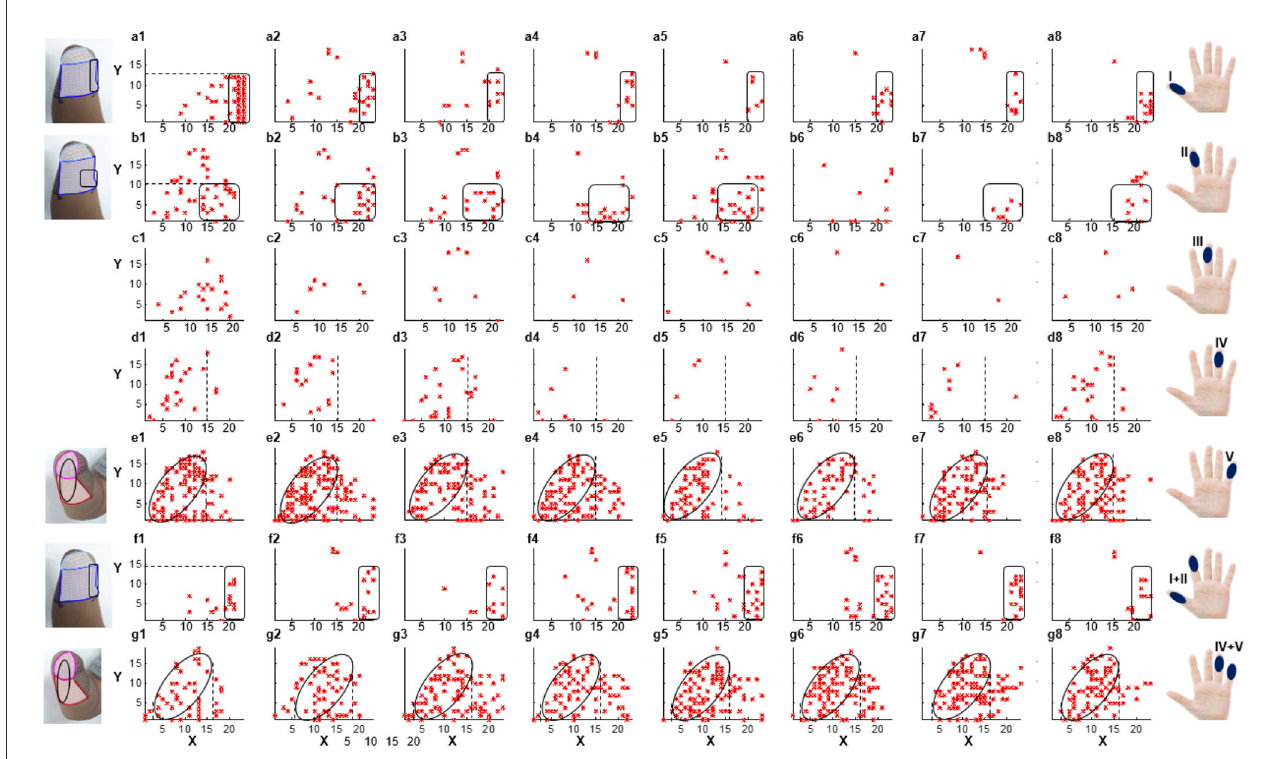
FIGURE3 The distribution of PHMs for the thumb (I), index (II), middle (III), ring (IV), and little (V) fingers, as well as the mixture of the thumb and index fingers (I + II), the ring and little fingers (IV + V). Both X- axis and Y- axis numbers correspond to the respective positions in the previous meshed